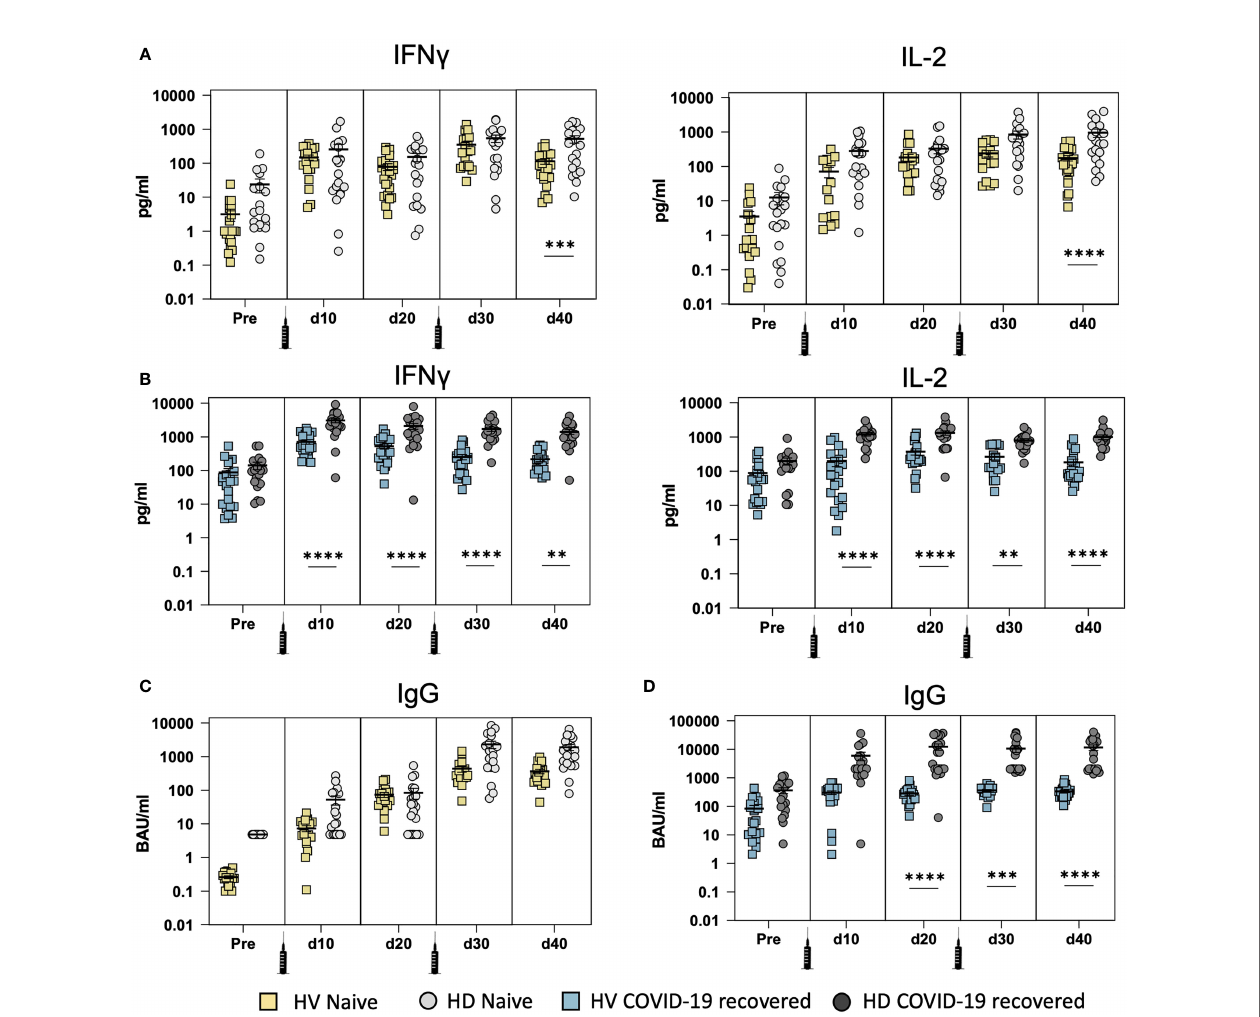
FIGURE 4 | Development of cellular and humoral immunity after SARS-CoV-2 vaccination in COVID-19 recovered and naïve hemodialysis (HD) patients vaccinated with mRNA-1273 vaccine (100 µg/dose) and in healthy volunteers (HV) vaccinated with BNT162b2 (30 µg/dose). (A) Comparison of IFN- ɣ and IL-2 production between naïve HD patients and HV at different time points: before vaccination (pre), after the fi rst (d10 and d20) and second (d30 and d40) mRNA vaccine dose. (B) Comparison of IFN- ɣ and IL-2 production in COVID-19 recovered HD patients and HV at different time points. (C) Comparison of SARS-CoV-2 spike-speci fi c IgG serum levels in naïve HD patients and HV. (D) Comparison of SARS-CoV-2 spike-speci fi c IgG serum levels in COVID-19 recovered HD patients and HV. ** <0.005, *** <0.0005, ****